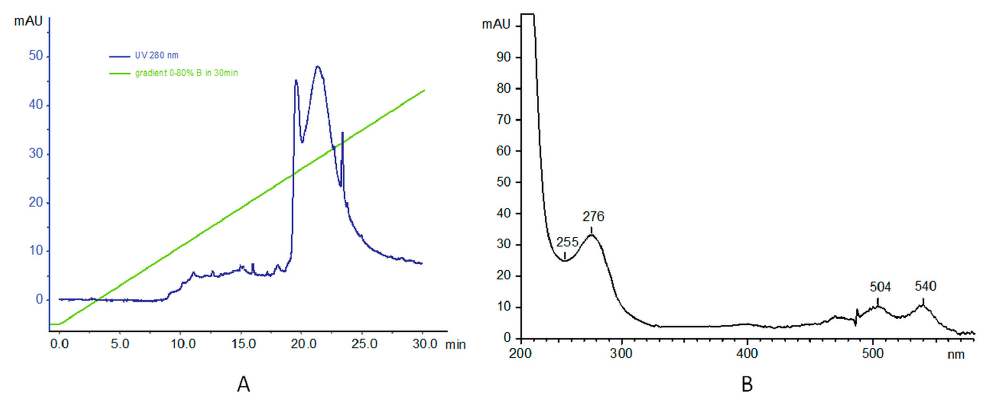
Figure 3. ( A ) RP-HPLC profile of PAMAM–dox–trastuzumab conjugate analysis; and ( B ) UV profile of the signal at 21 min.